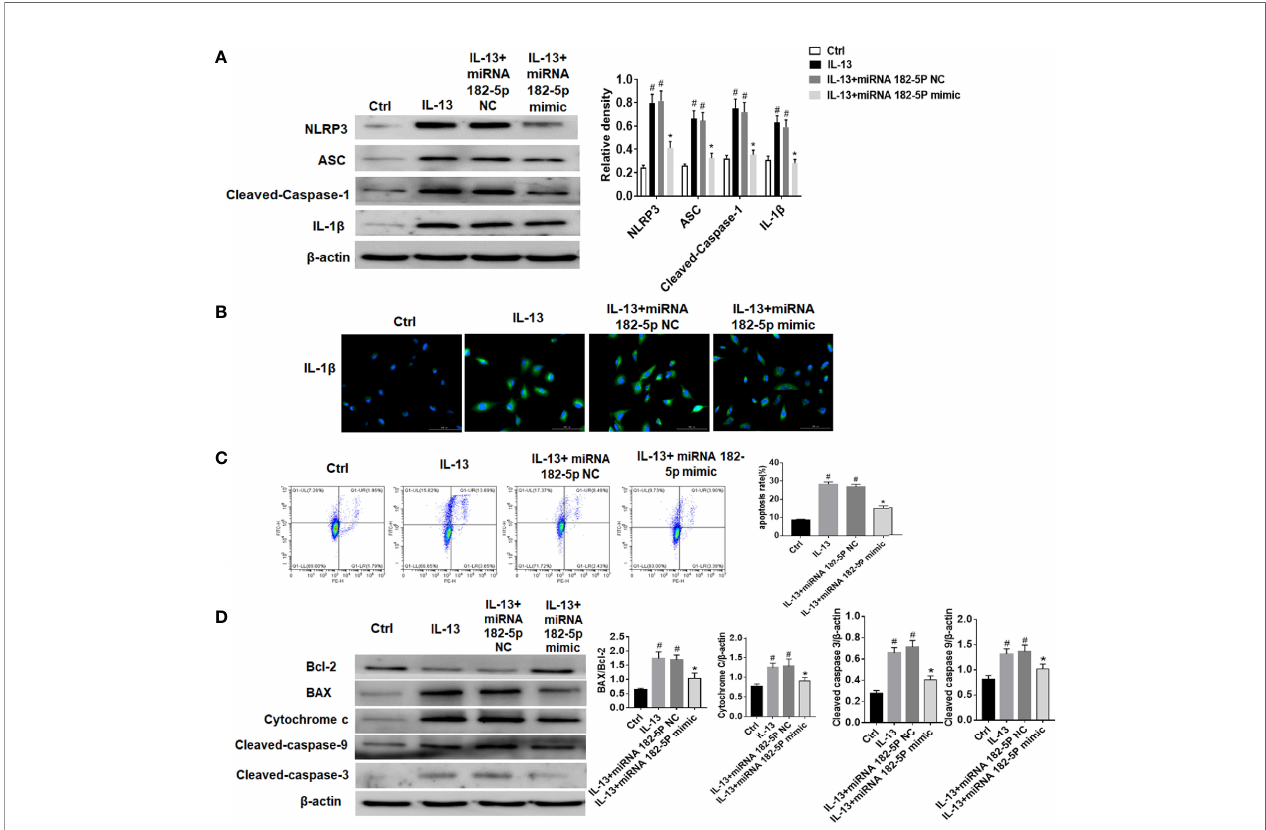
FIGURE 7 | MiRNA-182-5p inhibits the activation of NLRP3/IL-1 b and apoptosis. MiRNA-182-5p mimic or NC was used to intervene before IL-13 stimulation of BEAS-2B cells. (A) Western blot results of NLRP3, ASC, Cleaved-caspase-1 and IL-1 b as well as IL-1 b protein cyto fl uorogram were shown. (B) Green fl uorescence represents IL-1 b and blue fl uorescence represents nucleus. Scale bar: 100 µm. (C) Different apoptotic ratios were determined by fl ow cytometry analysis. (D) The expression of BAX, Bcl-1, cytochrome c, Capsese-9 and 3 was analyzed by Western blot. All data were shown as mean ± SD (n = 3). # p < 0.05 versus control, * p < 0.05 versus IL-13 group as determined by one-way analysis of variance (ANOVA) and Dunnett ’ s post hoc